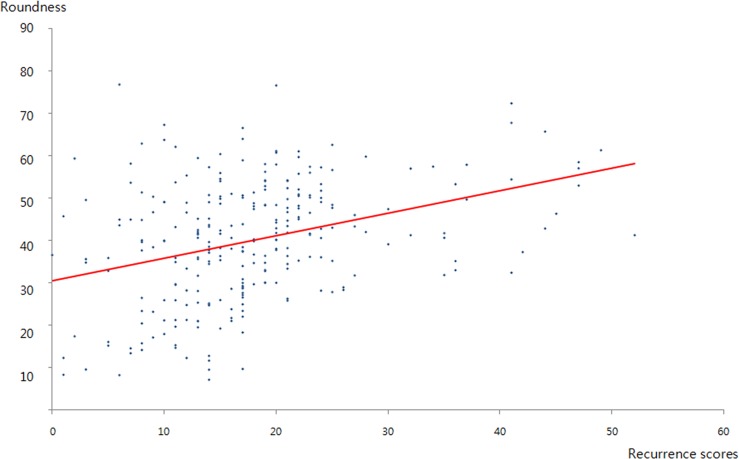
Correlation between the tumour roundness and recurrence score.The correlation plot shows a positive relationship between the tumour roundness and recurrence score (r = 0.349).